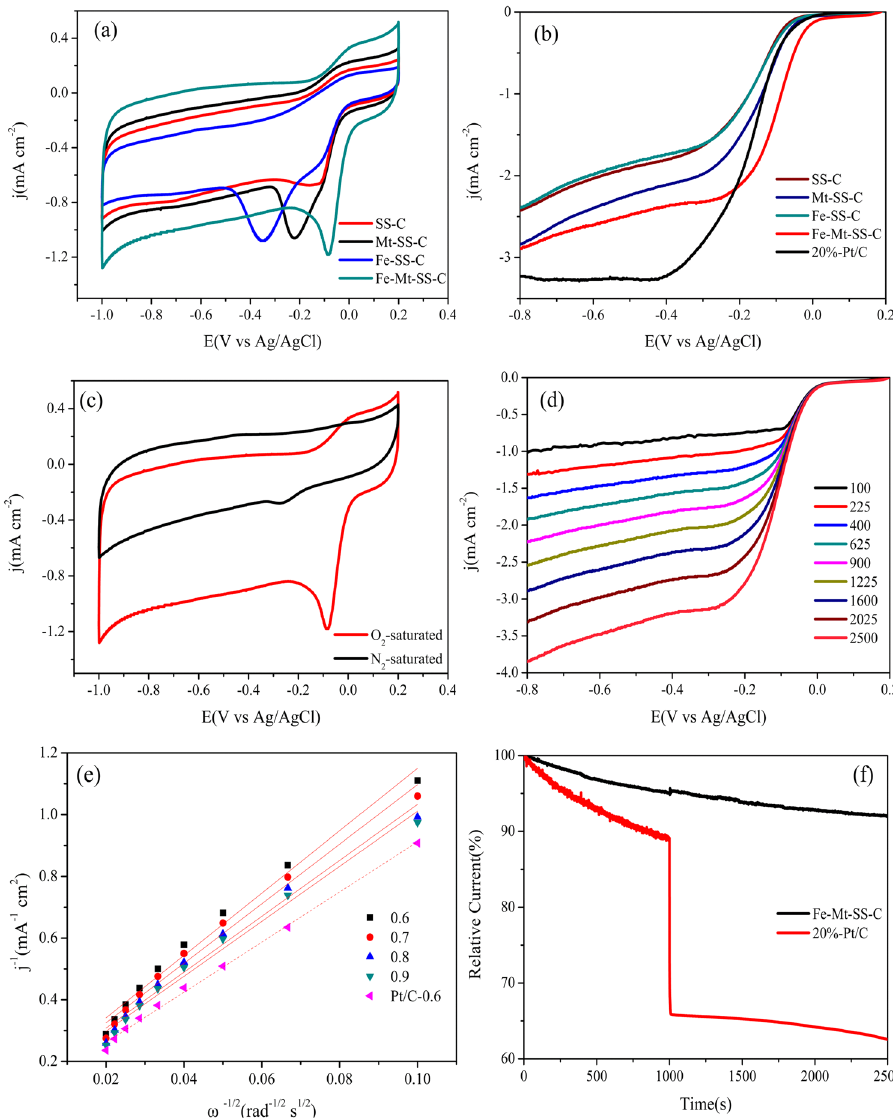
Figure 6. ( a ) Cyclic voltammograms of as-obtained materials in O 2 -saturated 0.1 M KOH at a scan rate of 10 mV·s − 1 ; ( b ) RRDE voltammograms of as-prepared materials and Pt/C at the rotation rate of 1600 rpm. Scan rate: 10 mV·s − 1 ; ( c ) Cyclic voltammograms of a Fe-Mt-SS-C in O 2 -saturated and N 2 -saturated 0.1 M KOH at a scan rate of 10 mV·s − 1 , respectively; ( d ) steady state polarization curves of O 2 reduction for Fe-Mt-SS-C in O 2 -saturated 0.1 M KOH at different rotation rates. Ring potential was set at + 0.5 V. Potential scan rate was 10 mV·s − 1 . ( e ) Koutecky-Levich plots of Fe-Mt-SS-C at different electrode potentials. ( f ) Chronoamperometric responses of Fe-Mt-SS-C and Pt/C electrodes with the addition of 3 M